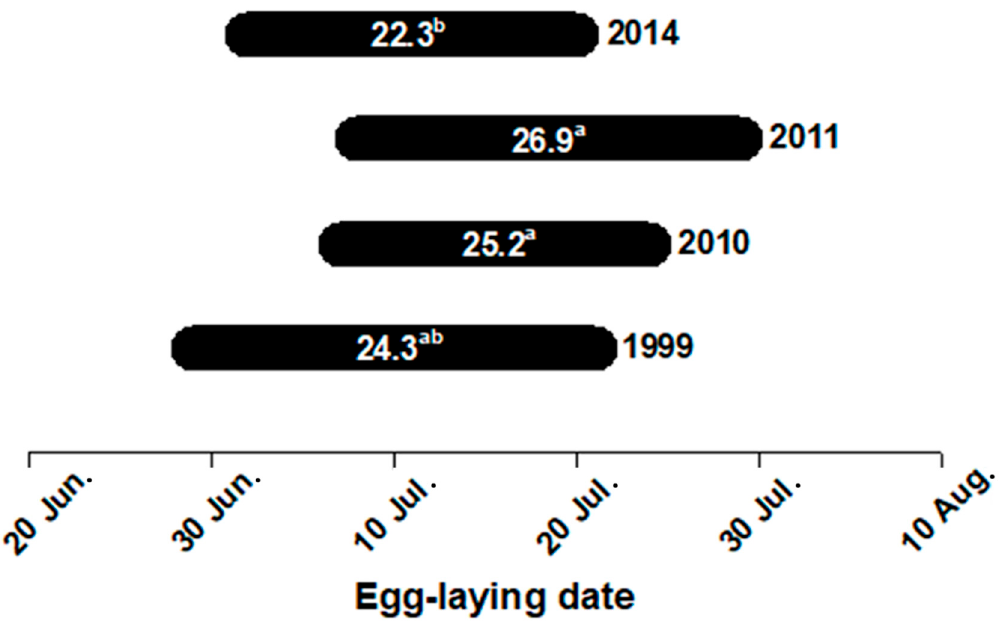
Figure 2. Egg-laying dates in four different years. Numbers on the horizontal bars indicate the mean number of days starting from 20 June. Means with different superscripts differ significantly (Tukey’s post hoc test, α = 0.05, a > b).